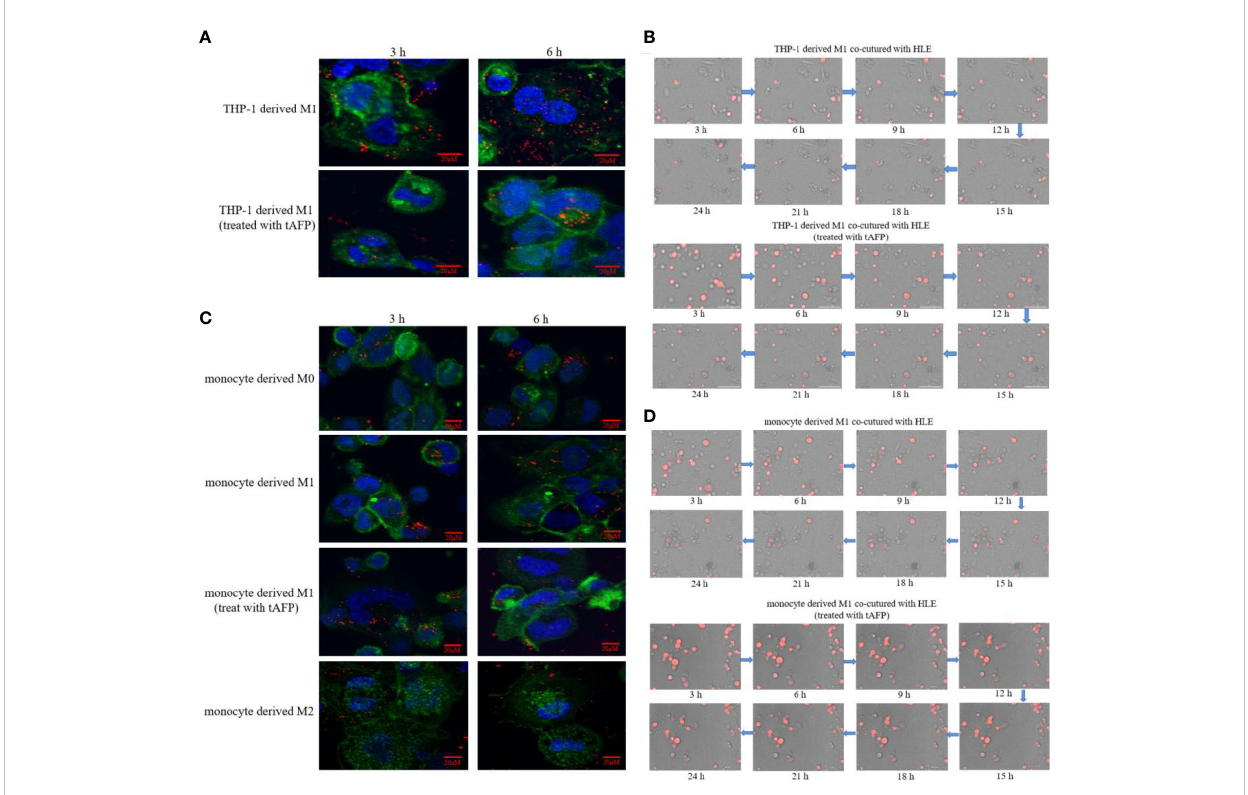
FIGURE 7 The effect of tAFP on macrophages phagocytizing polystyrene latex beads or HCC cells. Monocytes from health donors were treated with PAM to induce the polarization into M0 macrophage, then M0 macrophages were administered with LPS+IFN- g or IL-4+IL-13 for 24 h to induce M0 macrophage polarize towards M1-like phenotype or M2-like phenotype(showed in Supplementary materials: S-Figure 2). The THP-1 derived M1-like macrophage(gray) or health monocytes derived macrophages(gray) co-cultured with polystyrene latex beads(red) or HLE cells(red), then treated with tAFP( fi nal concentration 20 m g/mL). (A) THP-1 derived M1-like macrophage co-culture with polystyrene latex beads and treated with tAFP, the images of macrophages phagocytize polystyrene latex beads were taken by laser laser confocal microscopy after co-culture for 3h or 6h. Blue: cell nucleus(DAPI stained); Green: